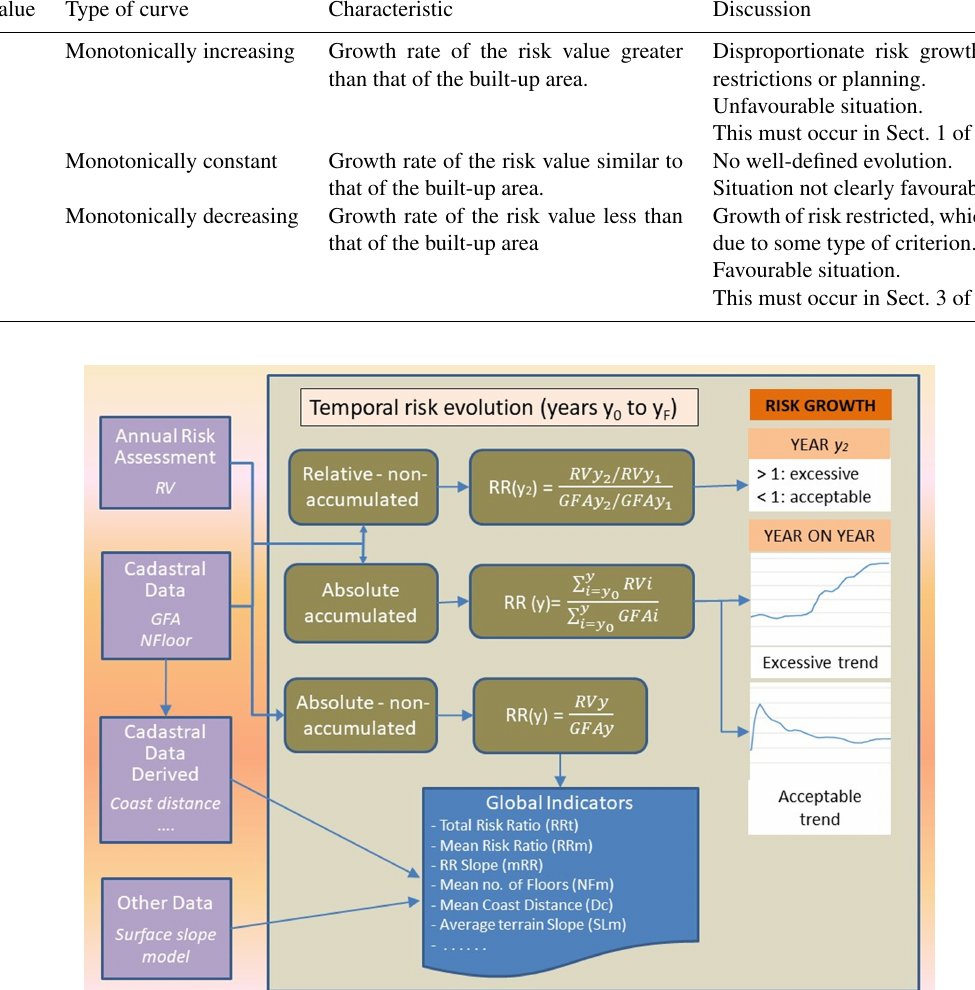
Figure 2. Curve trend of different types of risk